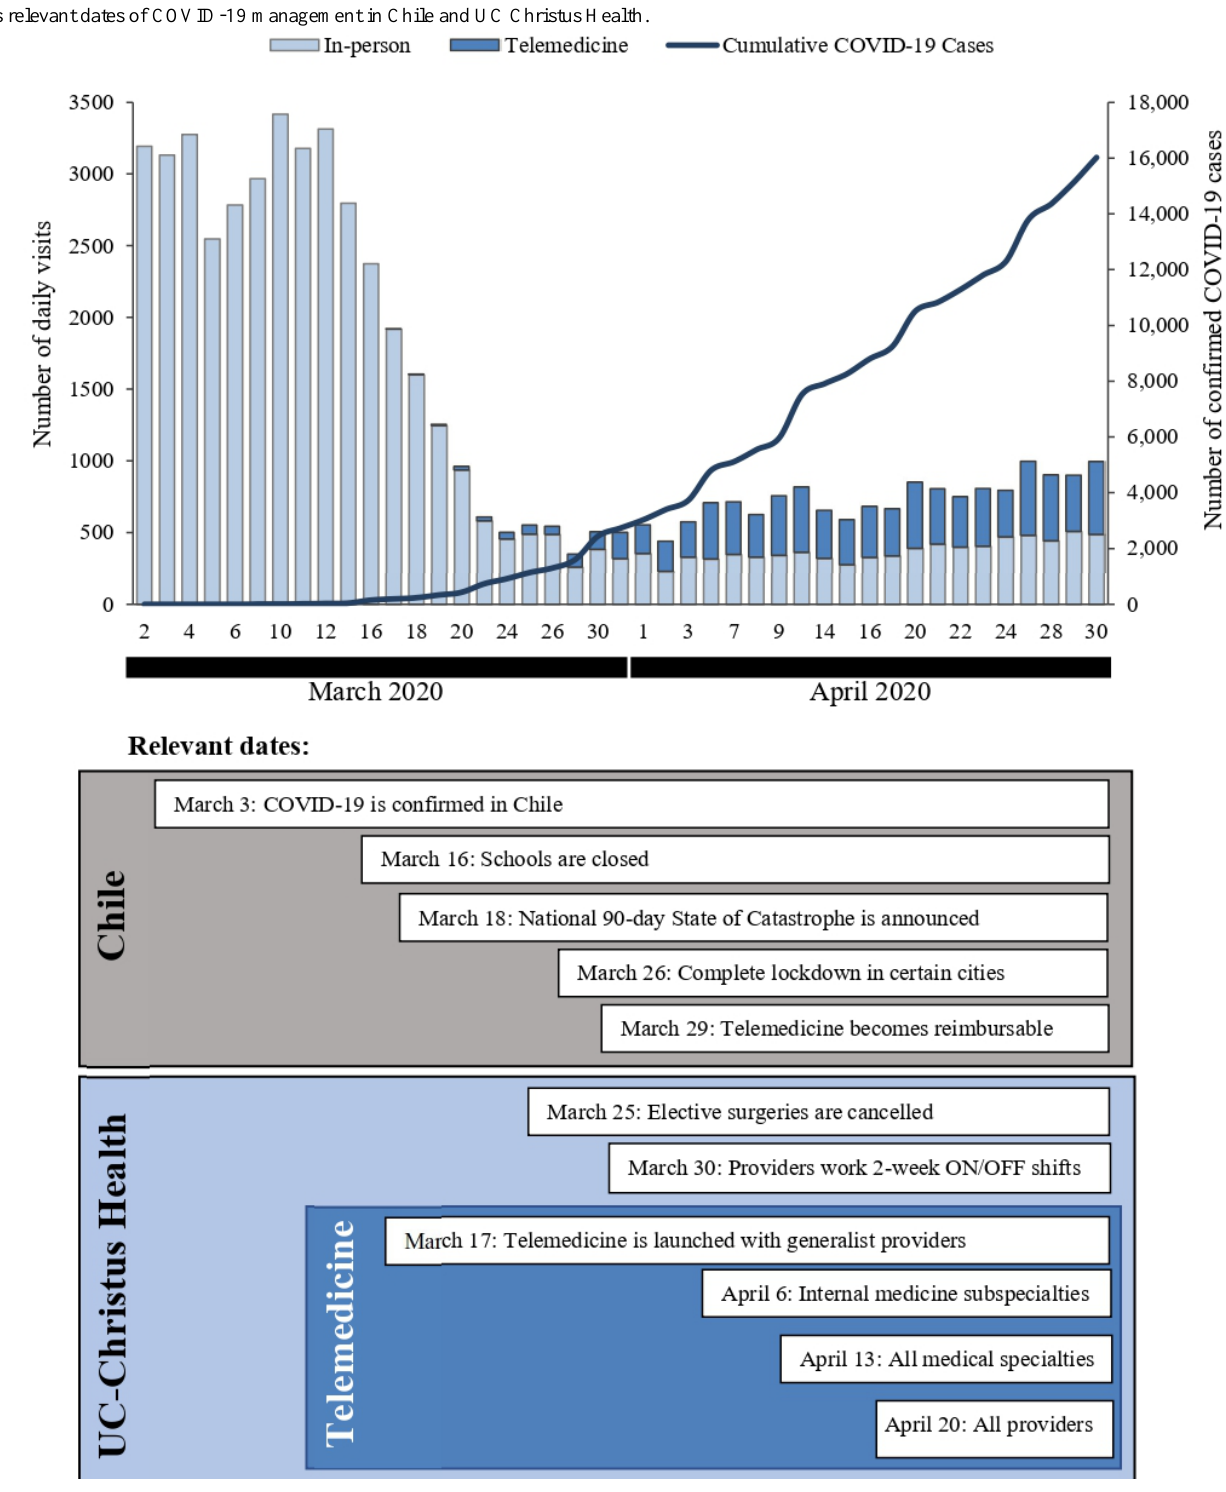
Figure 1. Rates of in-person and telemedicine visits at UC Christus Health and cumulative COVID-19 cases from March 1 to April 30, 2020, as well as relevant dates of COVID-19 management in Chile and UC Christus